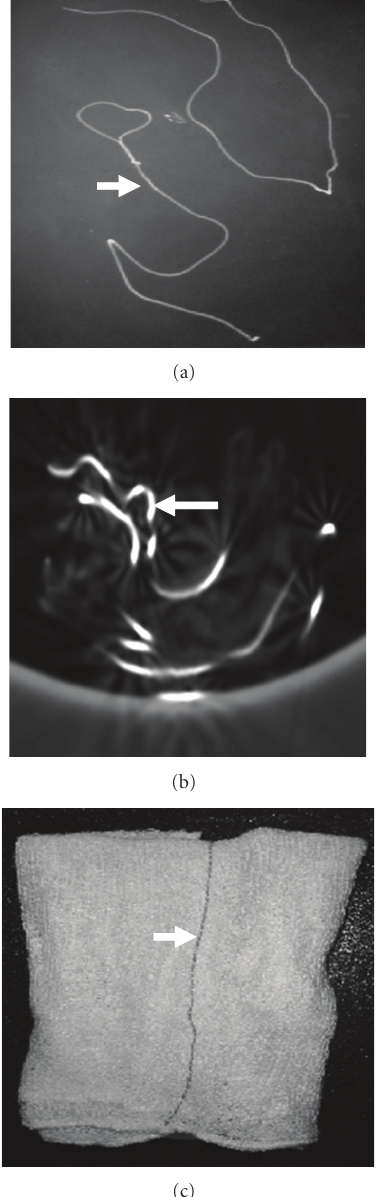
Figure 3: Plain X-ray (a), CT scan (axial section) of the surgical sponge (b), in lung window setting and the photograph of the surgical sponges, having radio-opaque markers (c). Radio-opaque markers are indicated by